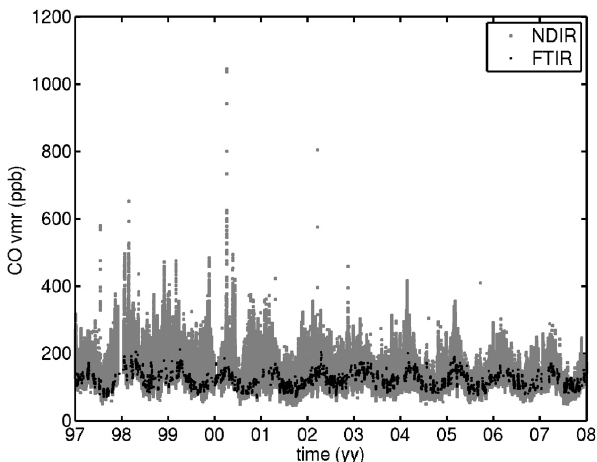
Fig. 1. CO concentrations (in ppb) as a function of time (year). All individual NDIR (grey) and FTIR data (black) prior to any selec- tion/correction